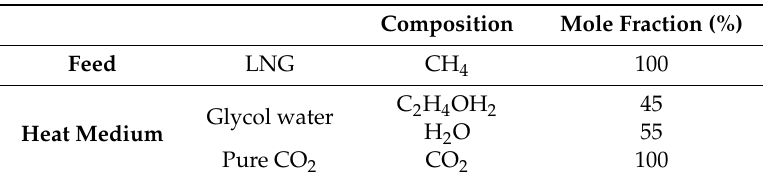
Table 3. System operating